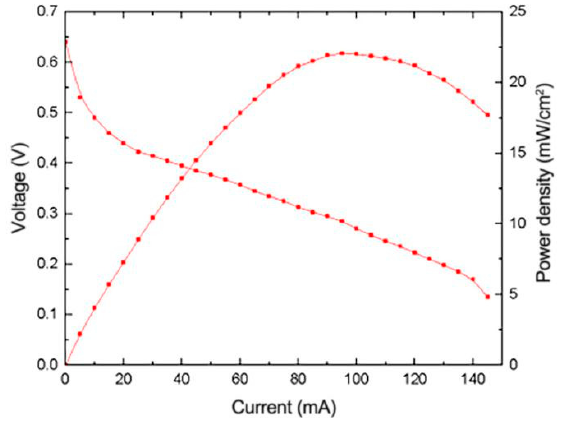
Figure 6. Performance curve of μ DMFC prepared under optimal process parameters.